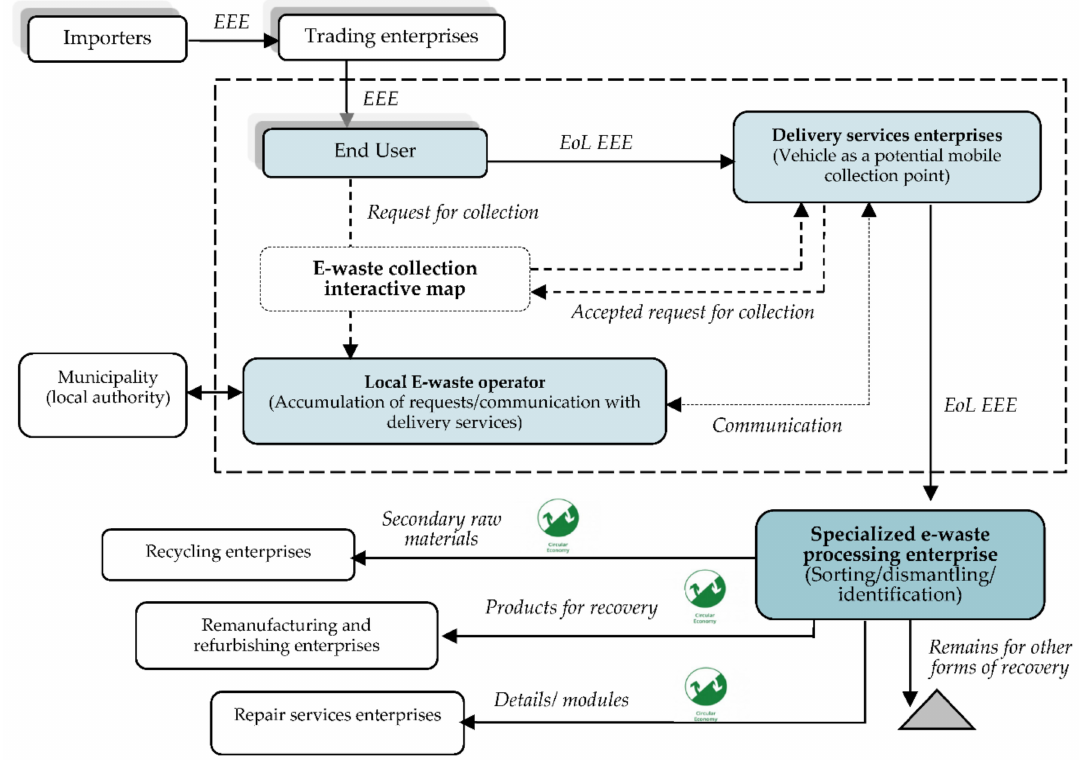
Figure 1. Structural and logical scheme of the smart e-waste reverse